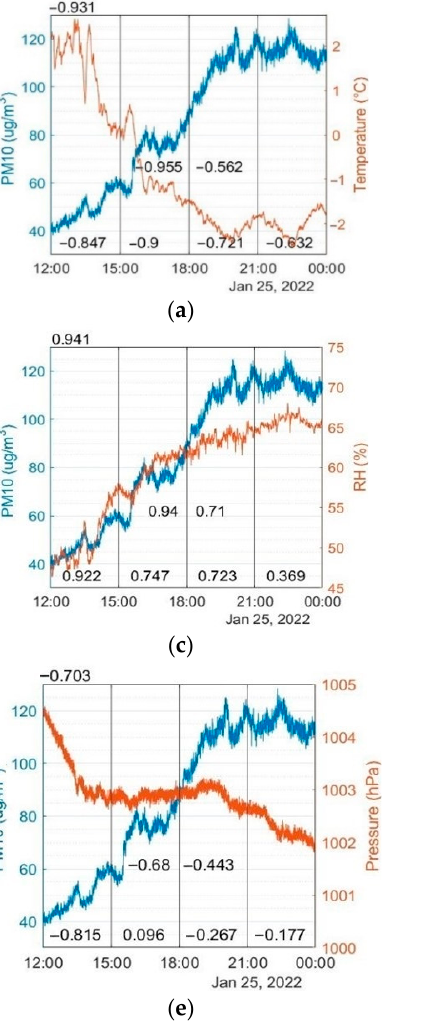
Figure 4. Changes in the measured quantities: PM10 and Temperature in January 2022 ( a ) 25th 12:00–24:00; ( b ) 26th 0:00–12:00; PM10 and Humidity on ( c ) 25th 12:00–24:00; ( d ) 26th 0:00–12:00; PM10 and Pressure on ( e ) 25th 12:00–24:00; ( f ) 26th 0:00–12:00. In Figure 4a it is apparent why r = − 0.931. The increase in PM10 mass concentration corresponds to the decrease in temperature, which is why r is of such high value with a negative sign. Similarly, in Figure 4c, the increase in PM10 mass concentration corre- sponds to the increase in Humidity, so r = 0.941 with a positive sign. Figure 4e is an answer to why r = − 0.703 for correlation between PM10 and Pressure. The barometric pressure is even though for the 3-h interval from 12:00 to 15:00, r = − 0.815. On the other hand, in Figure 4f r = − 0.003 for the 12-h interval. However, for the 3-h or 6-h intervals r shows moderate